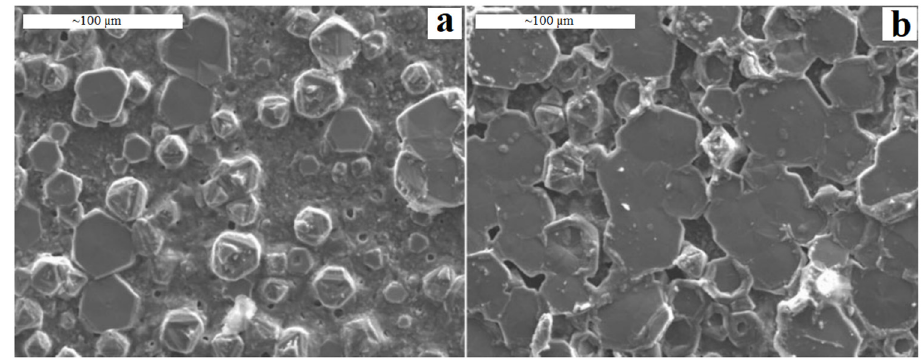
Figure 4. SEM images of HAp coating dried at 500 °C and calcined at 800 °C with ( a ); ( a ): rapid heating rate and ( b ): slow heating rate [118], reprinted with permission from Taylor & Francis Ltd.